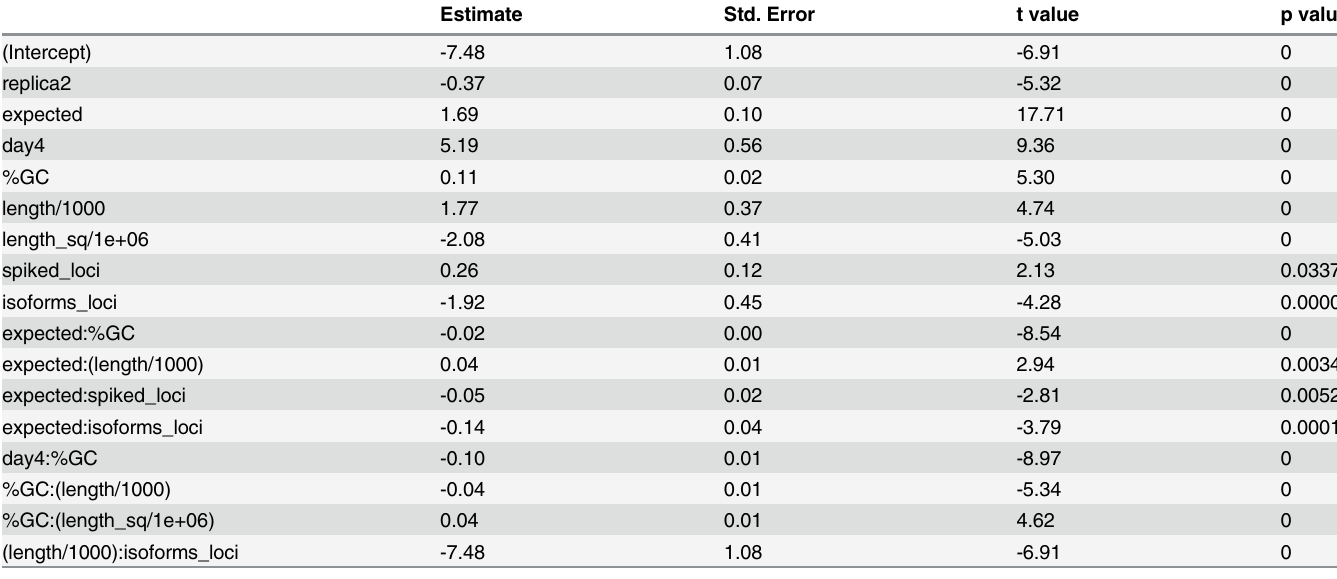
Table 5. Linear regression model using normalized RSEM FPKM values for all spike-ins. Estimate Std.